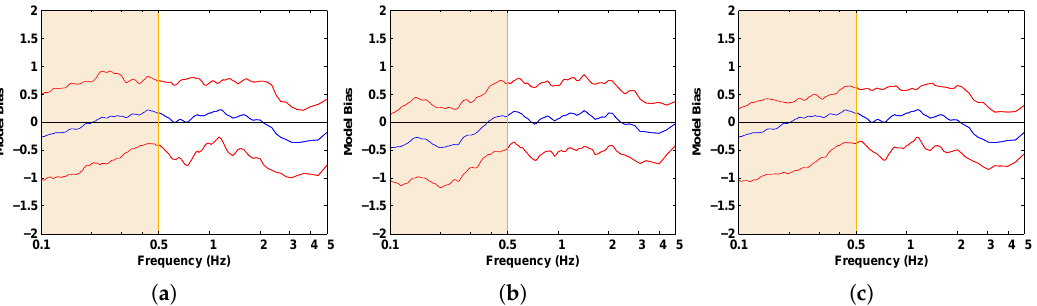
Figure 11. Bias in the synthetic associated with 5%-damped acceleration response spectra at 32 stations relative to the corresponding spectra of recorded ground motion during the 1999 Hector Mine earthquake. Blue line: Bias. Red line: Standard error. ( a ) North component, ( b ) East component, and ( c ) Geometric mean horizontal component.